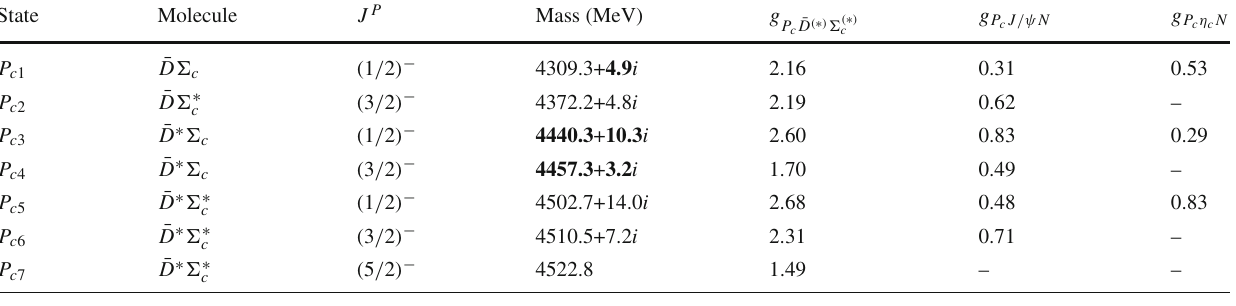
Table 4 Masses of the ¯ D ( ∗ ) (cid:2) ( ∗ ) c molecules as well as ( ∗ ) their couplings to ¯ D ( ∗ ) (cid:2) c , J /ψ N and η c N in Scenario B for a cutoff (cid:4) = 1 . 5 GeV. The bold figures are the experimental values used as inputs [91]. The symbol – denotes that the P c state does not couple to that particular channel